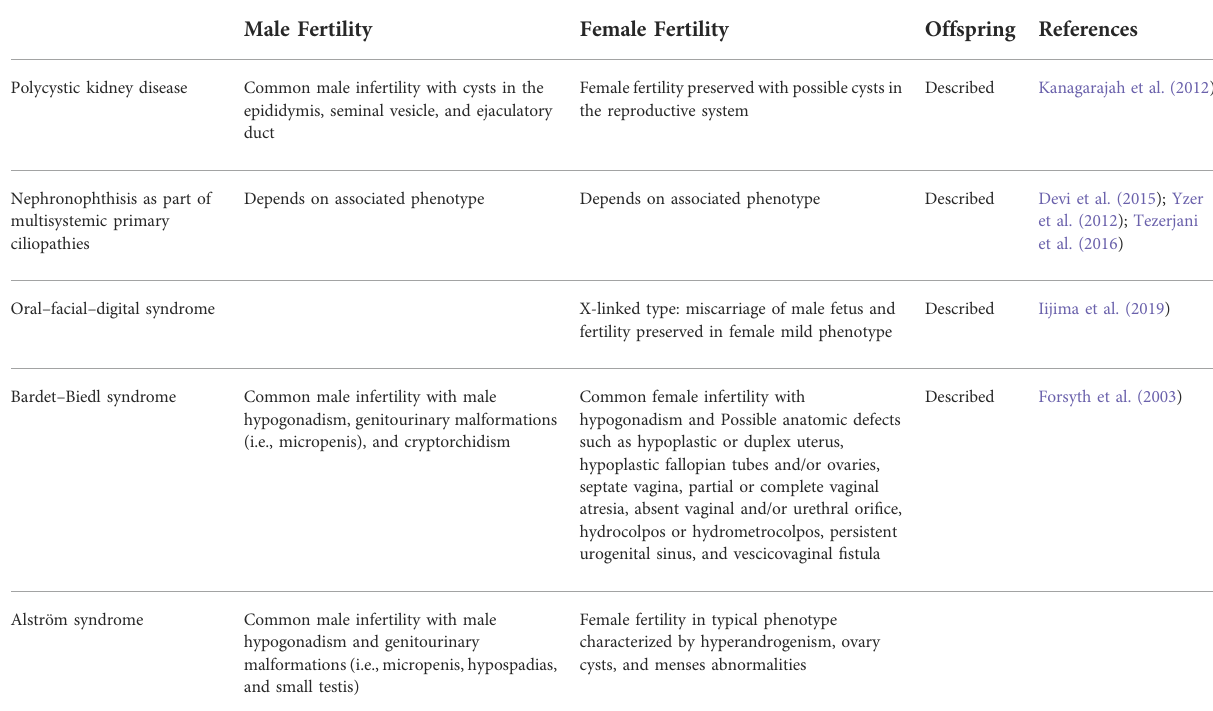
TABLE 3 Main primary ciliopathies and fertility issues. Male